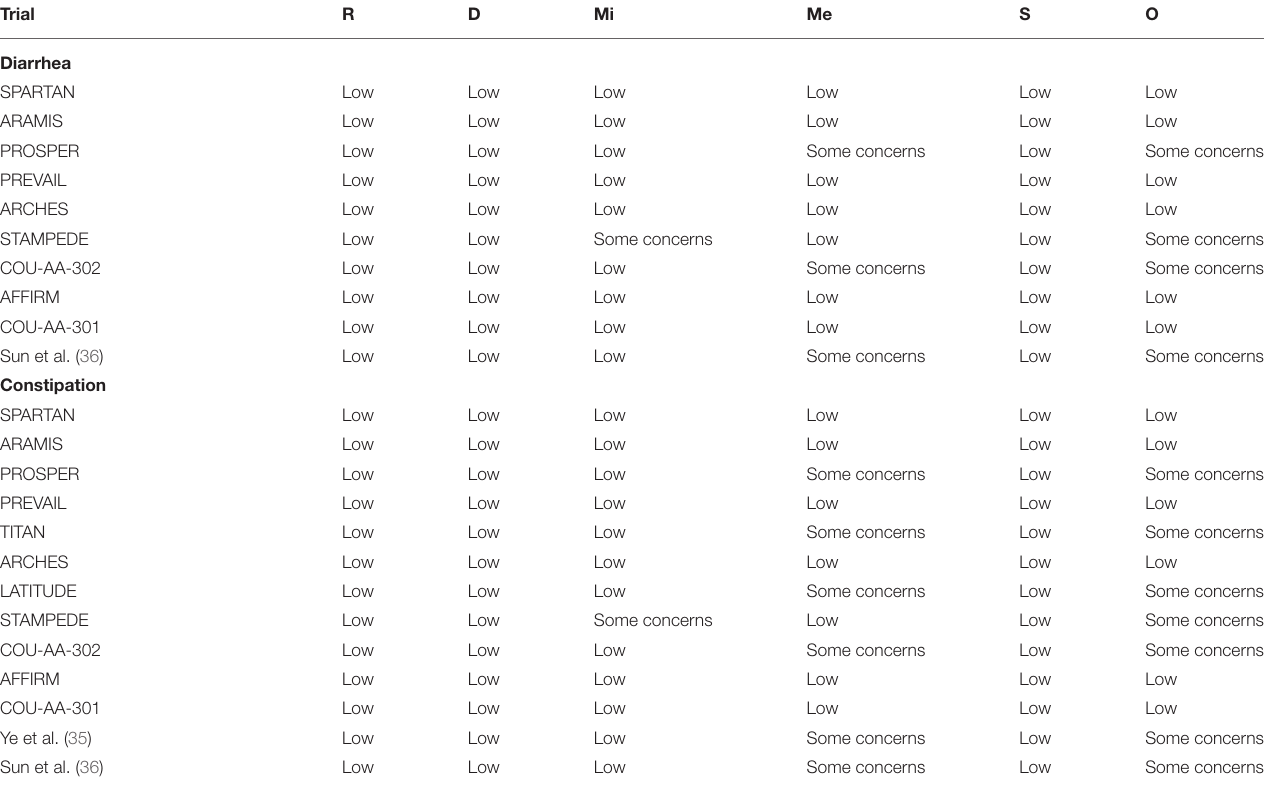
TABLE 2 | Risk of bias within trials.